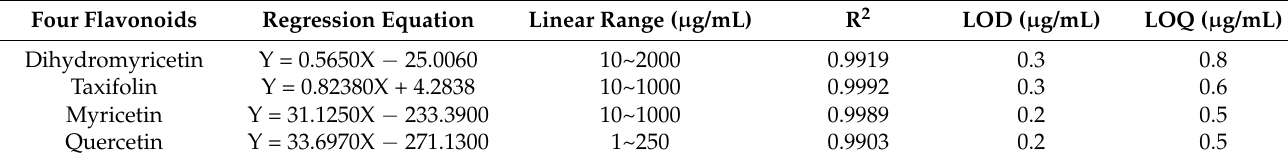
Table 4. Standard curve equation detection.